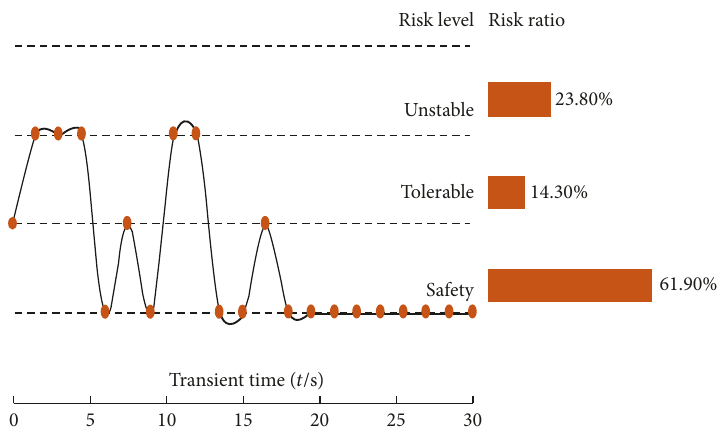
Figure 8: Dynamic safety assessment results of the predictive HGS during the load rejection transient process.